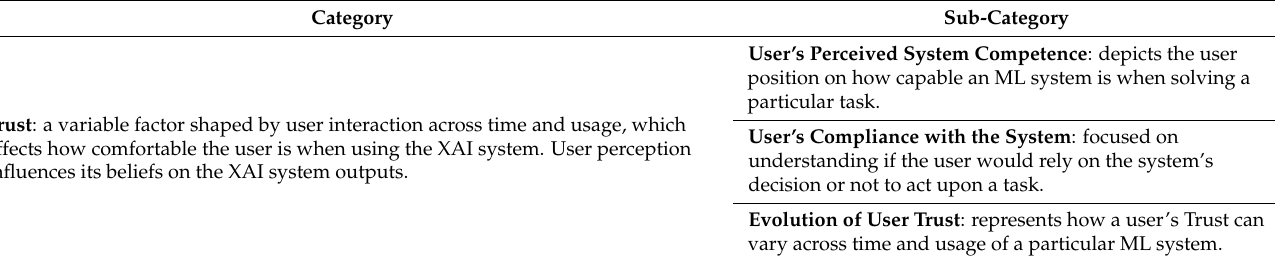
Table 1. Human-centred evaluation methods: categories and sub-categories.